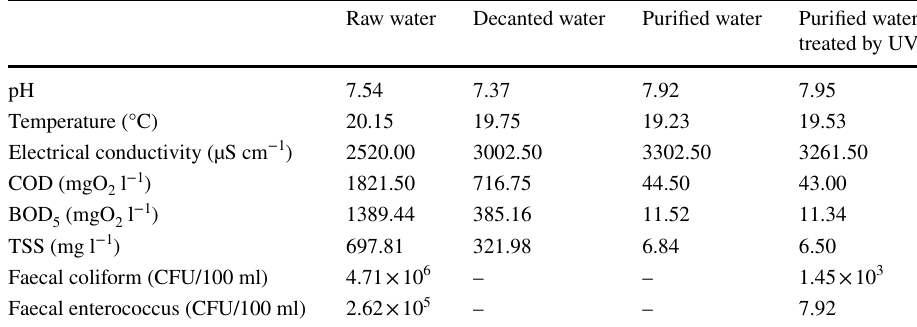
Table 1 Bacteriological and physicochemical quality of treated wastewater of the M’zar treatment plant (mean values). Source : Bourouache et al.